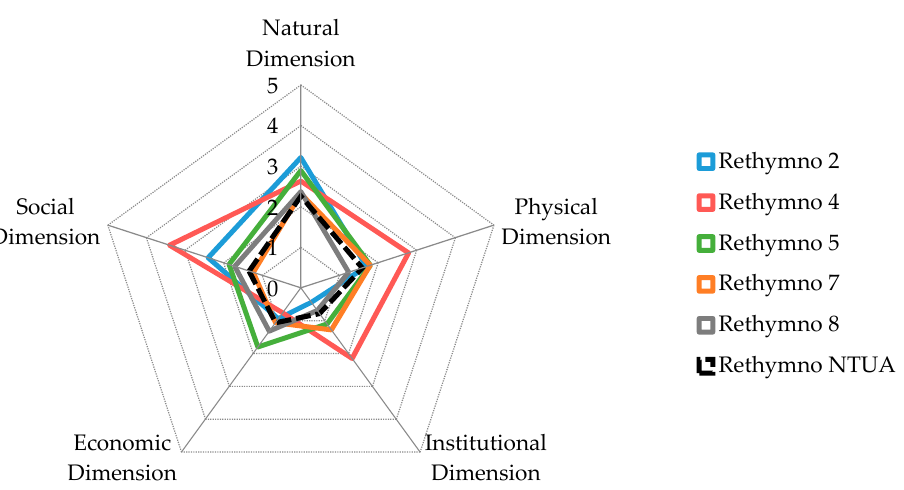
Figure 18. Spider diagram of Rethymno’s resilience for extreme flood events.